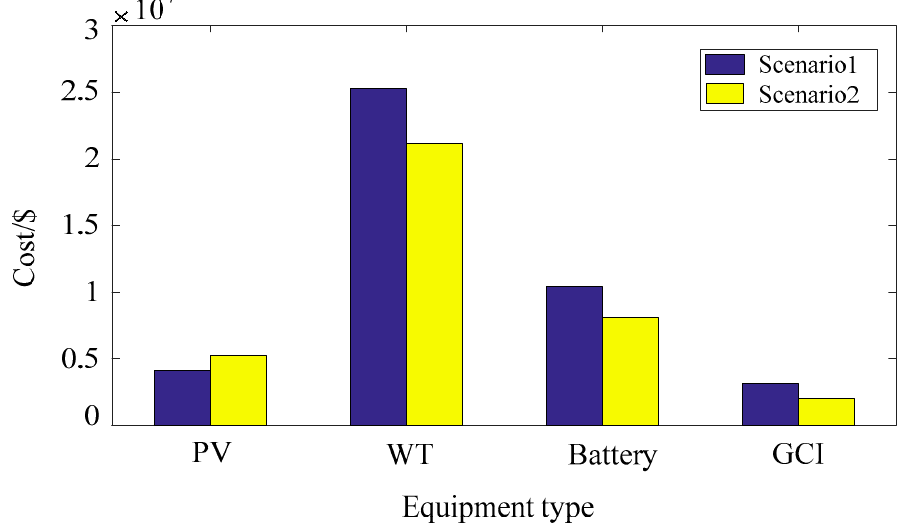
Figure 7. Cost of equipment in different scenarios.